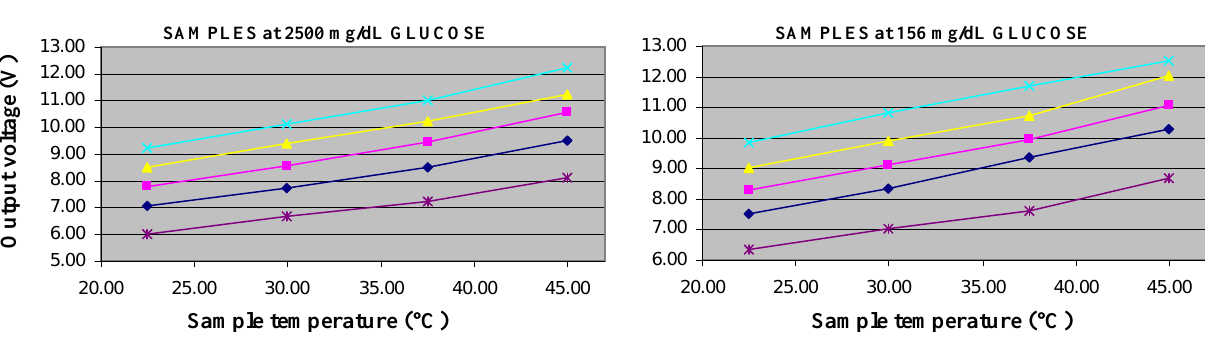
Figure 5. Output voltage of the electromagnetic sensor in relation to the sample temperature (room temperature, 30 °C, 37.5 °C, 45 °C) in the Ringer-lactate set (star), in the sodium chloride 0.9% set (rhombus), 1.0% set (square), 1.1% set (triangle), 1.2% set (x symbol), for fixed glucose concentration of 2,500 mg/dL (left) and  156 mg/dL (right), with pump powered at 10